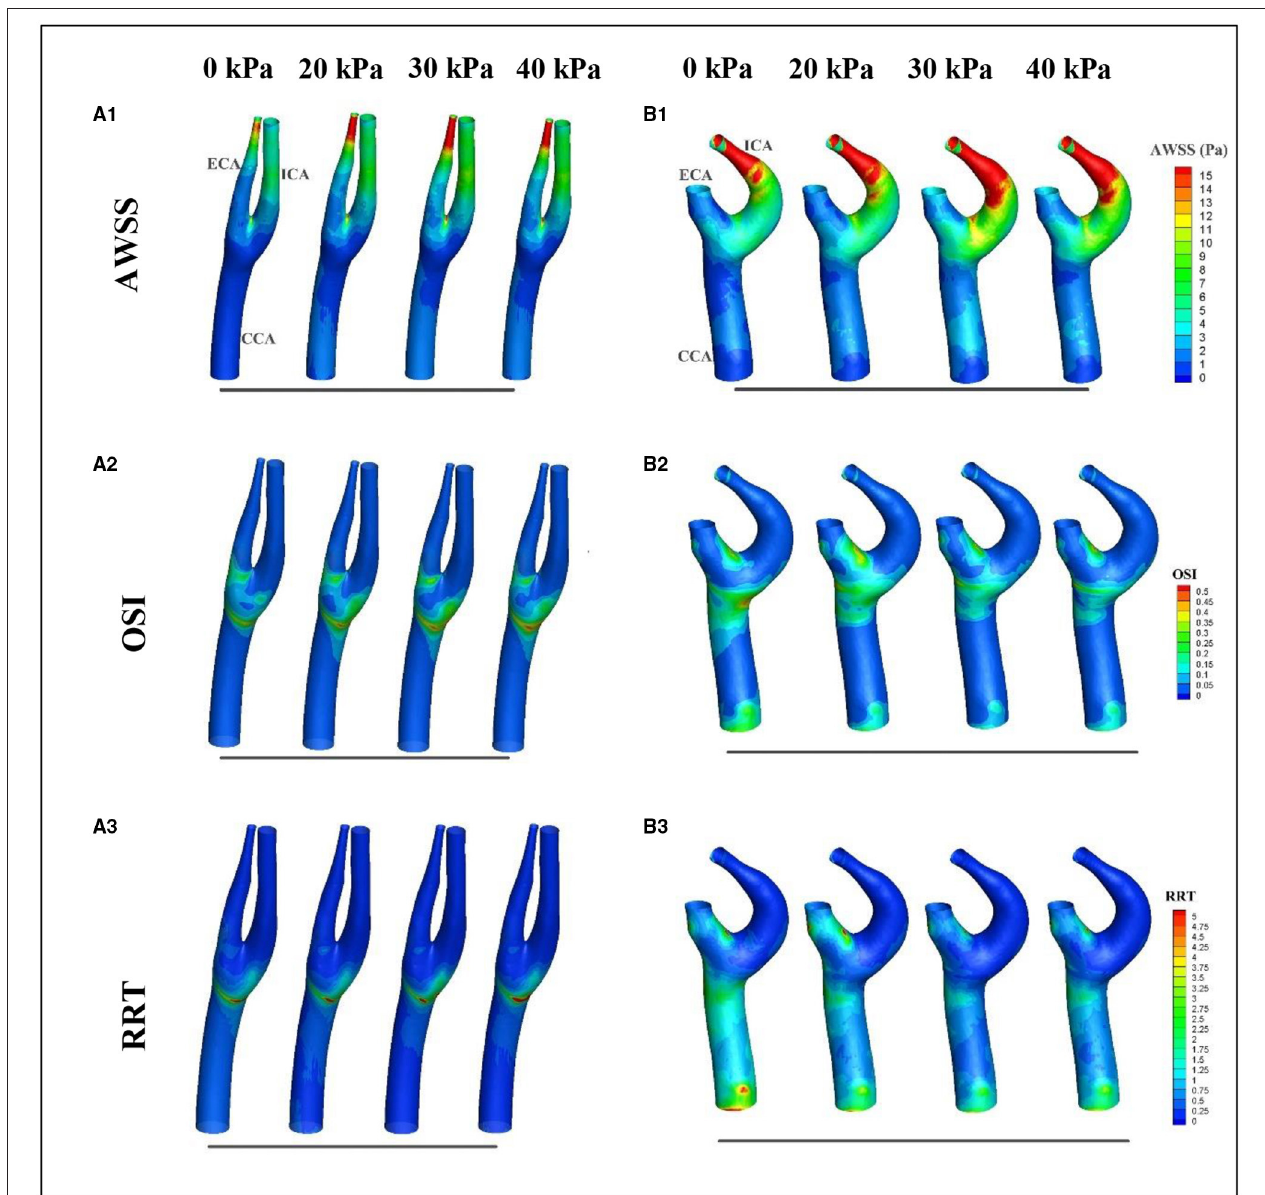
FIGURE 5 | Variations in wall shear stress (WSS)-derived hemodynamic factors over the cardiac cycle before and during EECP: (A,B) represent the healthy subject and the patient, respectively; 1, 2 , and 3 represent averaged wall shear stress (AWSS), oscillatory shear index (OSI), and relative resident time (RRT),